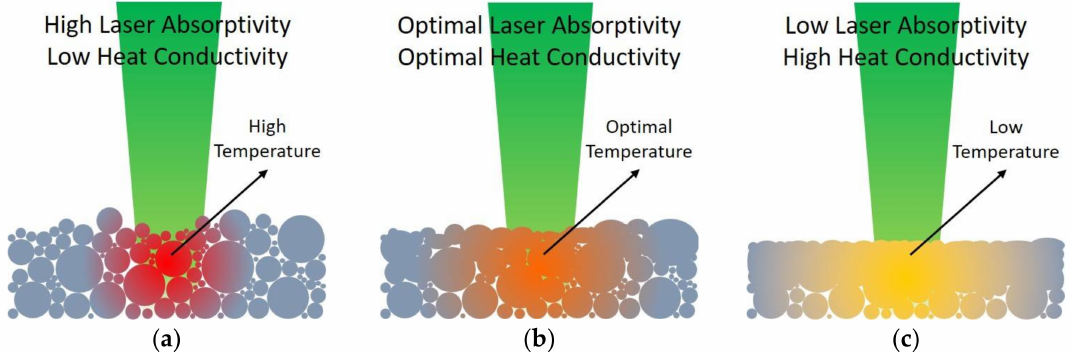
Figure 3. Schematic of the differences in the laser absorptivity and heat conductivity of NiTi materials before and after S1: ( a ) powder bed or poor-melted sample; ( b ) optimized sample; and ( c ) excessively- melted